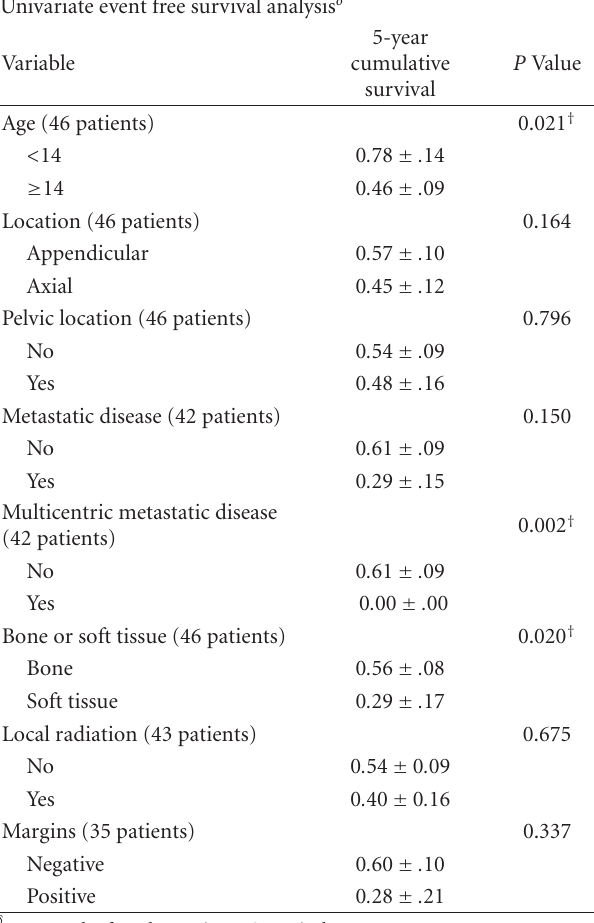
Table 6: Univariate analyses of variables for Event free survival (EFS).